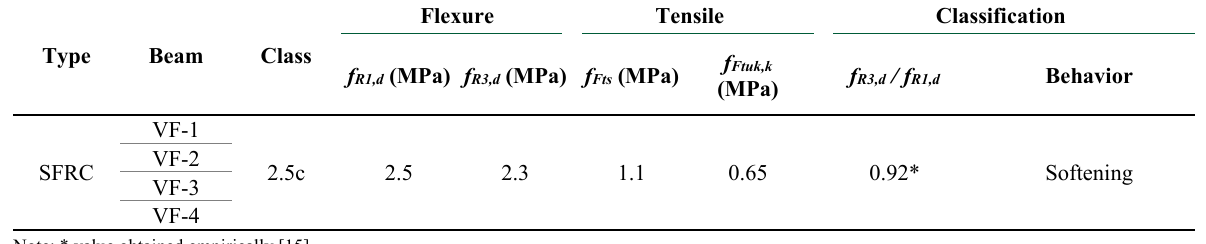
Table 8. Residual stresses at SFRC flexure and tensile (Model Code 10) [9]